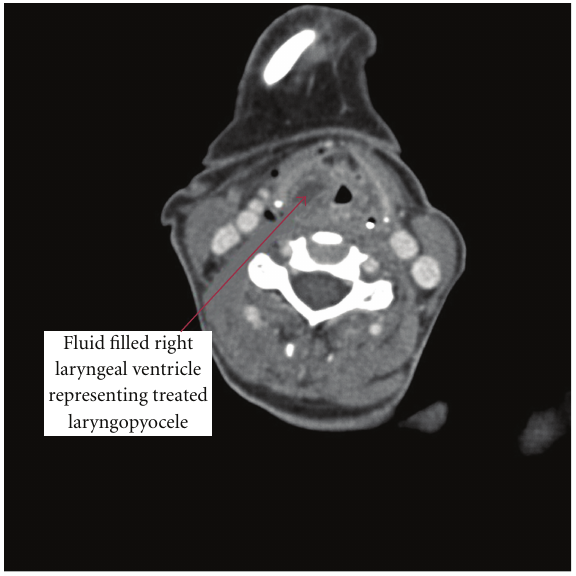
Figure 2: CT image immediately postoperatively with evidence of the marsupialised laryngopyocele on the right.